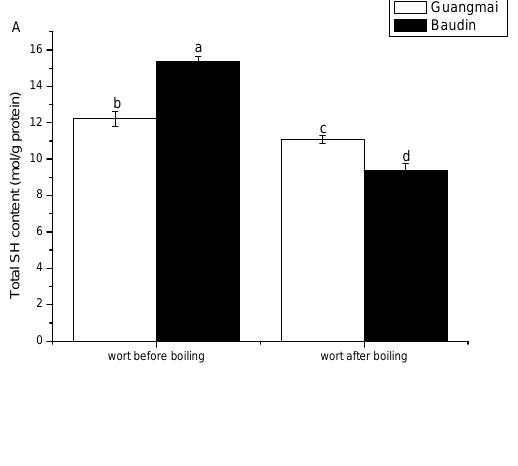
Figure 3 . Total SH contents of wort proteins (before and after boiling) with the two varieties. Results are means and standard deviations of replicates. Different characters (a-d) on the top of a column indicate the significant differences (p<0.05) between wort proteins with the two varieties during the boiling.